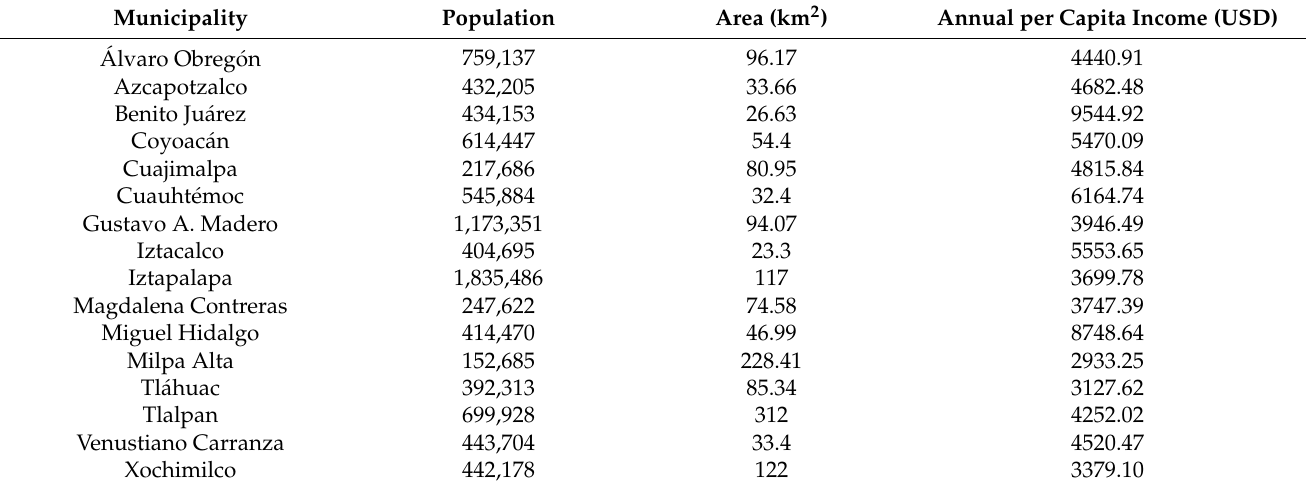
Table 2. Municipalities: population, area and annual per capita income